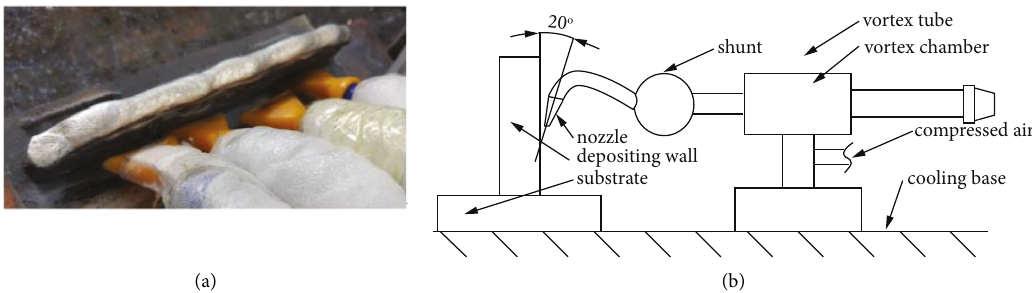
Figure 8: Vortex cooling system: (a) physical diagram and (b) schematic